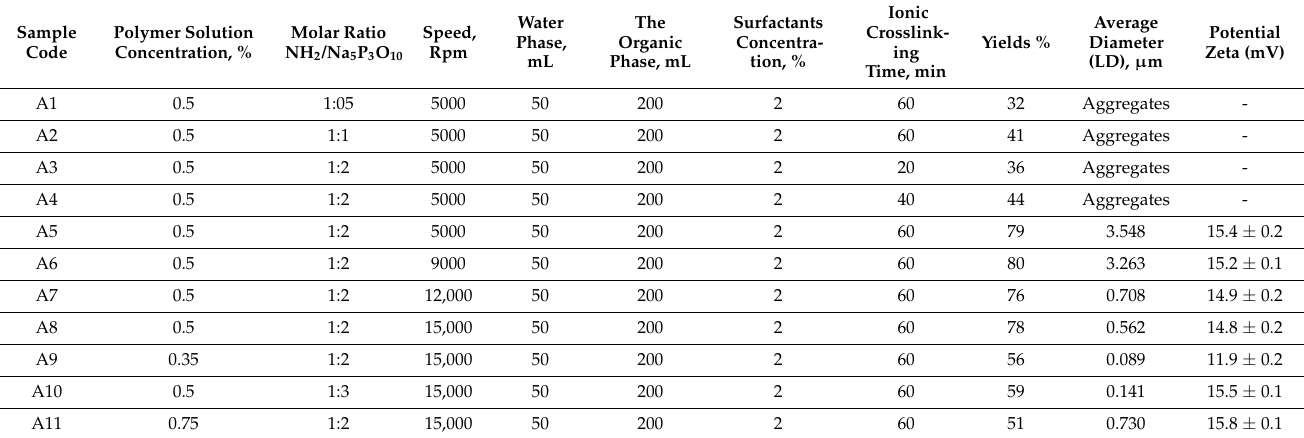
Table 1. CPH—preparation parameters and size measurements. Sample